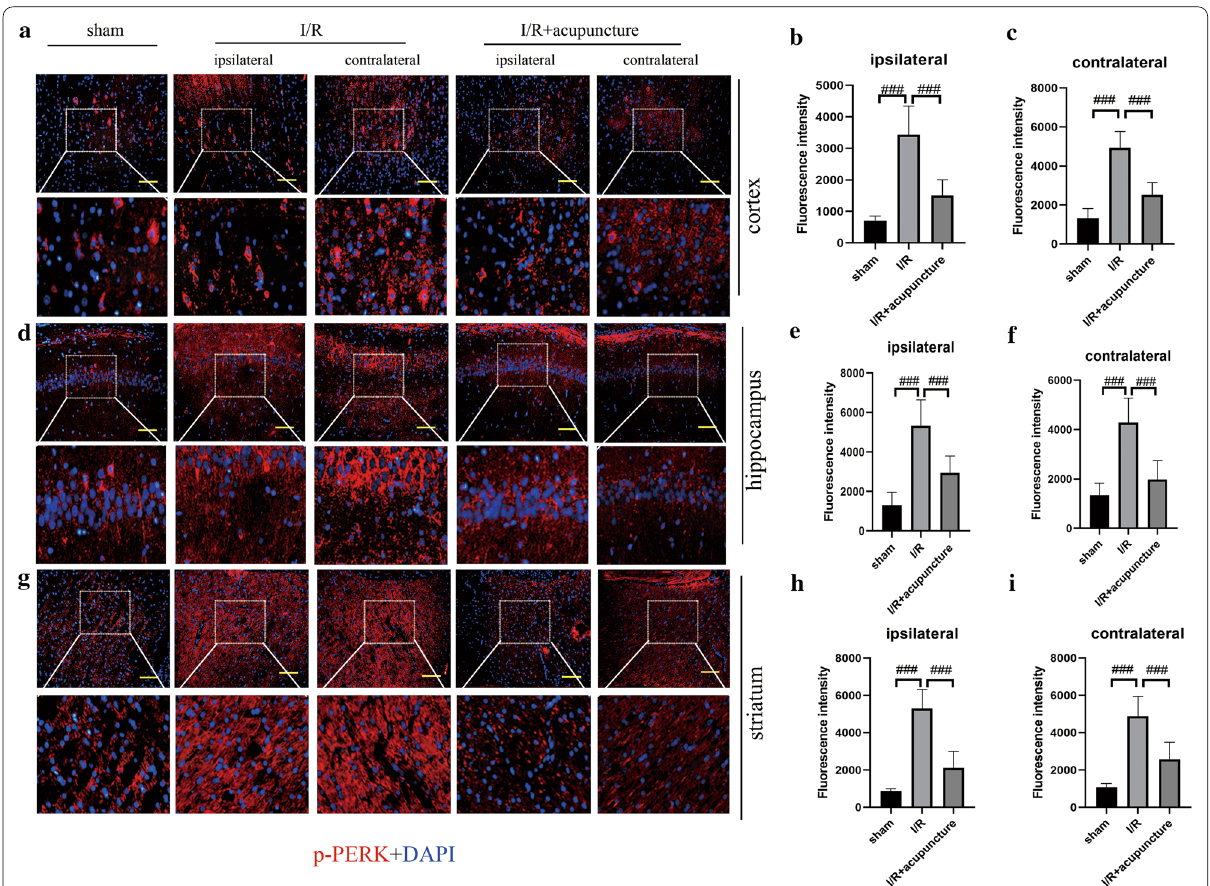
Fig. 5 Acupuncture repressed cerebral ischemia–reperfusion (I/R) injury-induced endoplasmic reticulum (ER) stress via inhibiting phosphorylated PKR-like ER kinase (p-PERK) expression. The expression of p-PERK (red) in cortex ( a – c ), hippocampus ( d – f ), and striatum ( g – i ) of contralateral and ipsilateral brains at 72 h after reperfusion was detected by immunofluorescence analysis. The nuclei were counterstained with DAPI (blue). Scale bars, 100 μm. Results represent at least three independent experiments. Each experimental result was presented as mean (n 6). ### P < 0.001 versus the indicated =